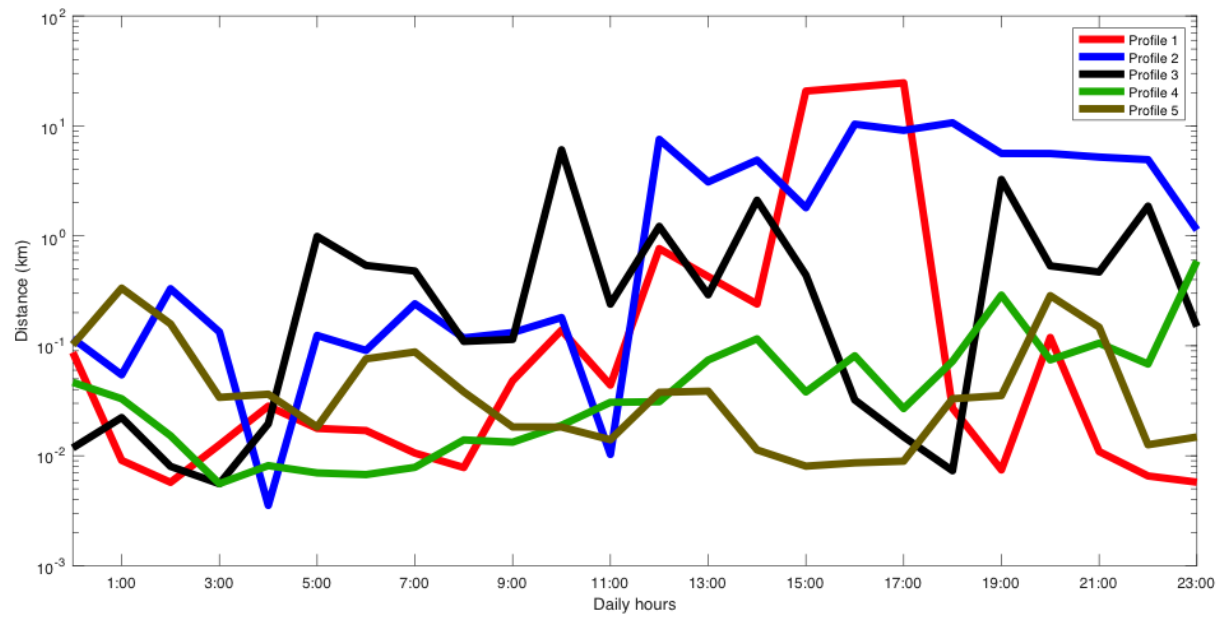
Figure 5. Distance traveled profiles of patient B.